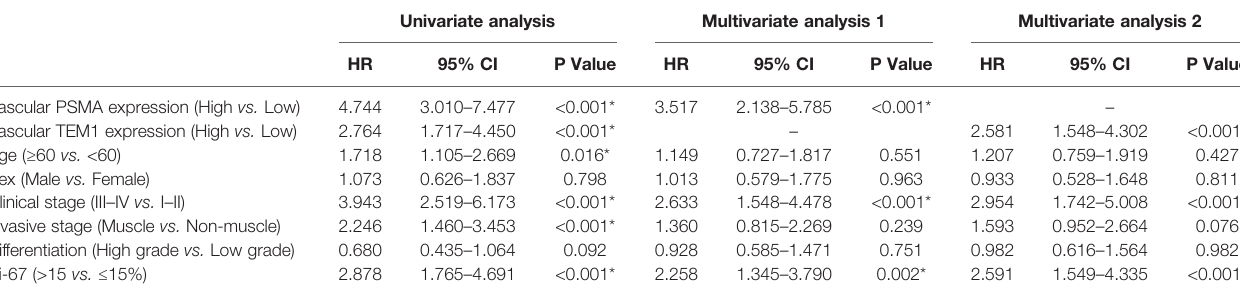
TABLE 3 | Cox regression analysis of prognostic factors for overall survival in UCB (n =